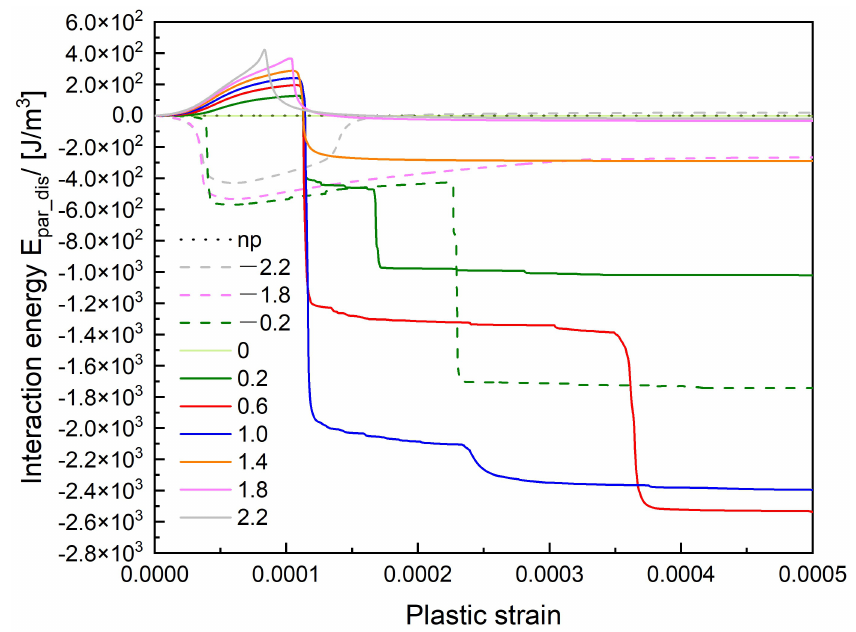
Figure 18. The interaction energy curve between the dislocation and precipitate.